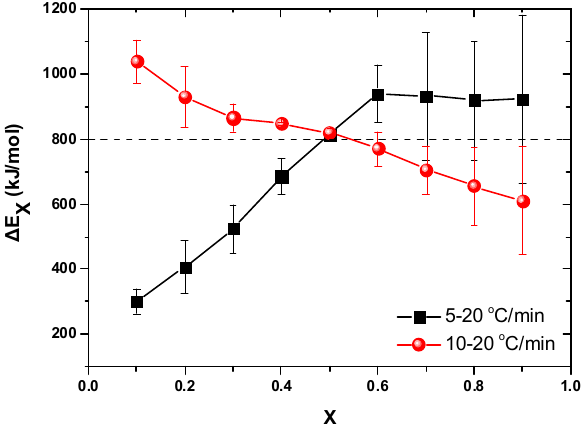
Figure 8. Variation of the effective activation energy with conversion at two different heating rate regimes (i.e., 5–20 and 10–20 °C/min).